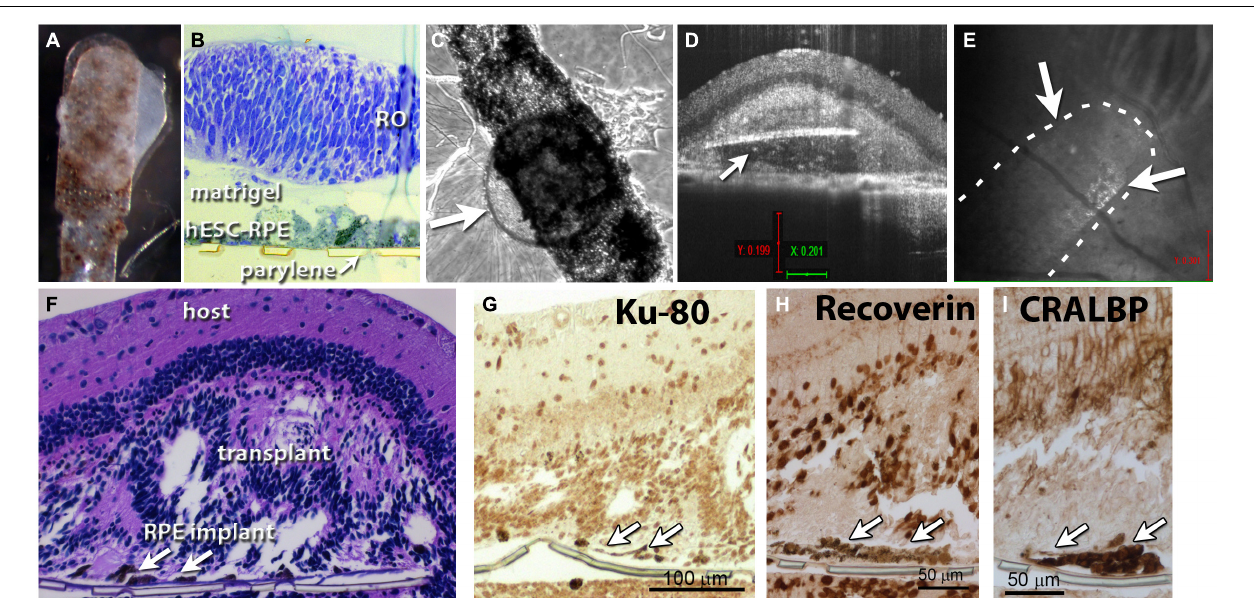
FIGURE 2 | Retina organoid + RPE implant on matrigel. (A) RO and RPE embedded together using matrigel. (B) Plastic section of tissue fixed 1 h after matrigel embedding. (C) After co-culture for 4 days, arrow points to retina organoid. (D) Optical coherence tomography (OCT) B-scan image 12 days after transplantation of the co-graft into a rat eye (A) . Arrow indicates parylene implant. (E) OCT fundus image showing the co-graft placement in the subretinal area of an RCS rat; arrows point to co-graft. (F) Histology of the transplanted eye (hematoxylin–eosin staining). Arrows point to parylene implant. (G) Staining for human nuclei (Ku-80). (H) Recoverin: photoreceptors and cone bipolar cells. (I) Staining for cellular retinaldehyde binding protein (CRALBP: Müller glia and